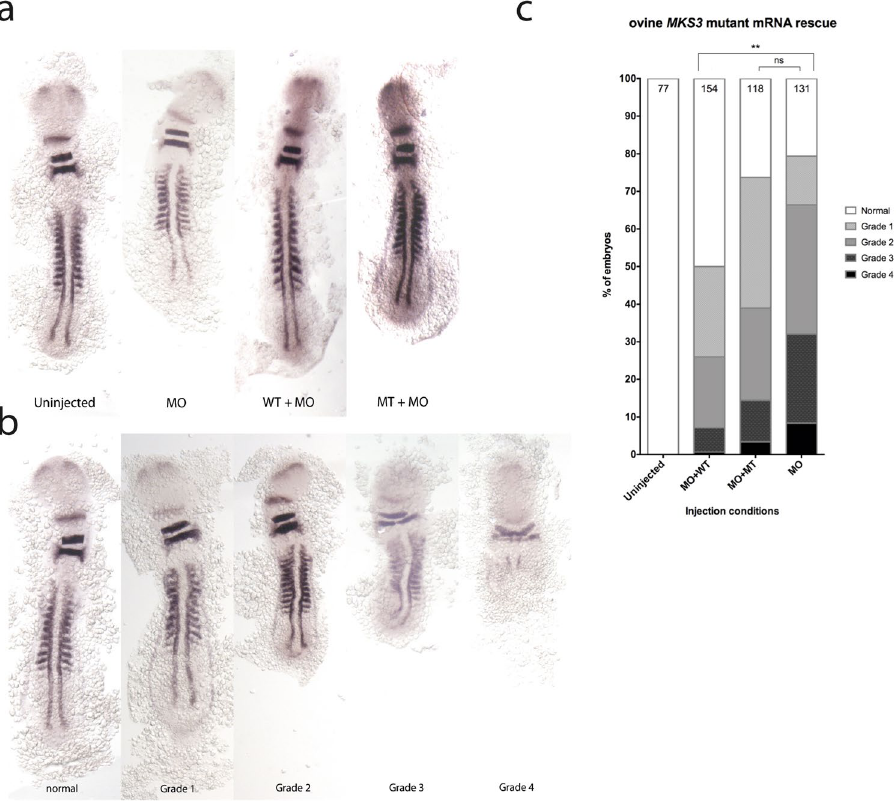
Figure 5. Loss of function of the TMEM67 transcripts containing missense mutations in a zebrafish phenotype rescue assay. ( a ) Bright-field microscopy of morphant zebrafish embryos stained with riboprobes against myod , pax2 , and krox20 using in situ hybridization. Uninjected, uninjected embryos. MO, embryos injected with morpholino. WT + MO, embryos co-injected with OaMKS3 mRNA plus MO. MT + MO embryos co-injected with mutant OaMKS3 ( I681N ; I687S ) mRNA plus MO. ( b ) Zebrafish embryos at the 11–12-somite stage stained by in situ hybridization with riboprobes against myod , pax2 , and krox20 . The graded embryos were injected with 0.17–0.33 pmol mks3 MO, while normal embryos were injected with the solvent (Danieau buffer and phenol red dye mixture). The grade 1 morphant shows a shortened body axis, kinked notochords, and wide somites compared with the normal embryo, and exhibited one or two out of the three developmental aberrations (see Methods). Embryos with grade 2 phenotypes showed all three structural defects to a moderate degree. Grade 3 embryos showed more severe developmental aberrations. The embryos with grade 4 phenotype showed severe developmental malformations and died within or soon after 14 hpf. ( c ) Graph showing the phenotypic rescue of mks3 morphant embryos co-injected at the 11–12 somite stage of development with ovine OaMKS3 mRNA plus MO and scored using in situ hybridization (ISH). The percentages of the 11–12 somite rescued zebrafish embryos (with 50 ng mRNA) are shown in different morphological grades. Embryos at the 11–12-somite stage were assessed by myoD , pax2 , and krox20 labeling using ISH and observed under a bright-field microscope. Co- injection of MO plus 50 ng ovine wild type OaMKS3 mRNA (MO + WT) resulted in a significant restoration of the normal phenotype in the morphant embryos compared with MO-injected embryos ( ** p < 0.0001, 2-tailed Fisher Exact test), whereas the co-injection of MO plus ovine mutant OaMKS3 ( I681N ; I687S ) mRNA (MO + MT) did not significantly restore the normal phenotype in the morphant embryos compared with morpholino-injected embryos (p = 0.2903). The number indicated at the top of each bar denotes the total number of embryos per injection condition. Abbreviations: MO, morpholino; WT, OaMKS3 mRNA; MT, OaMKS3 ( I681N ; I687S ) mRNA; ns, not